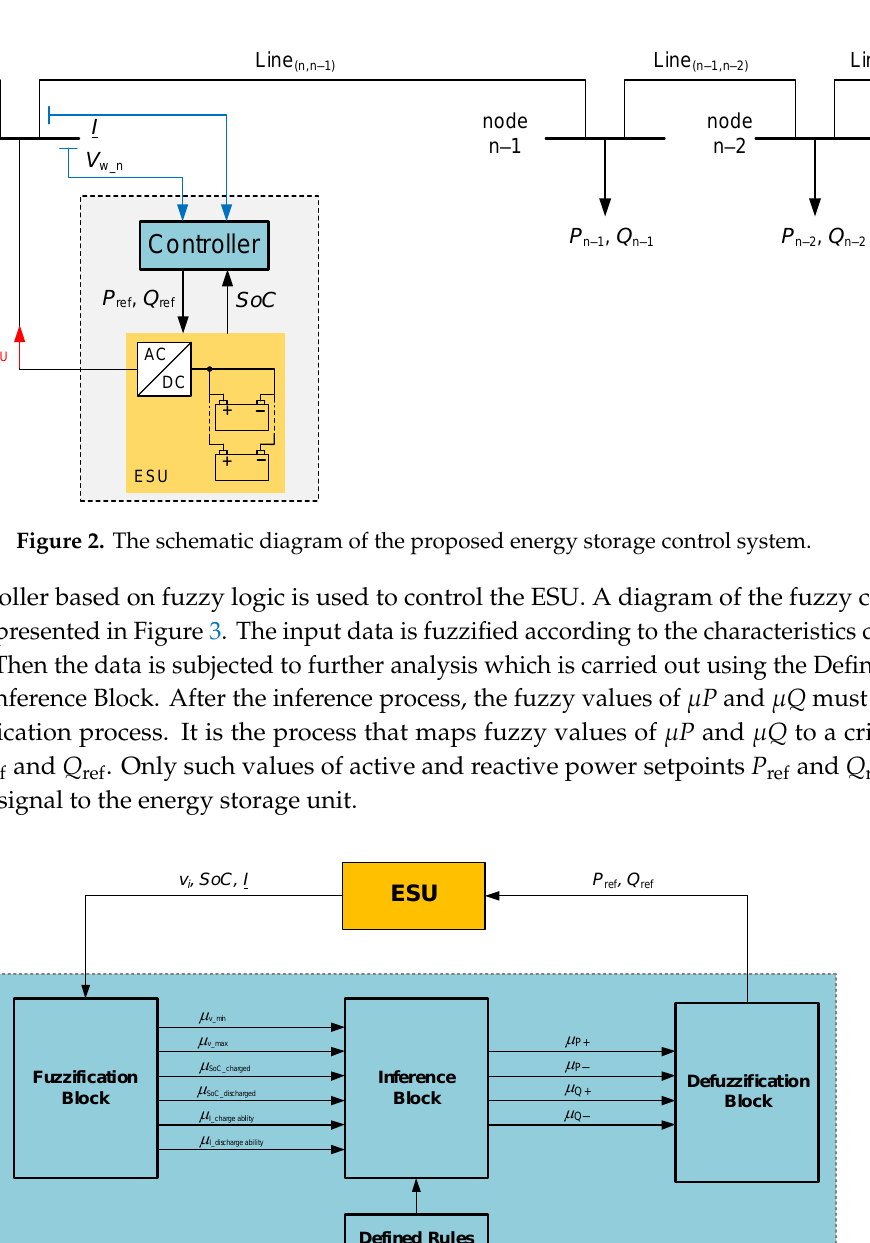
Figure 2. The schematic diagram of the proposed energy storage control system.